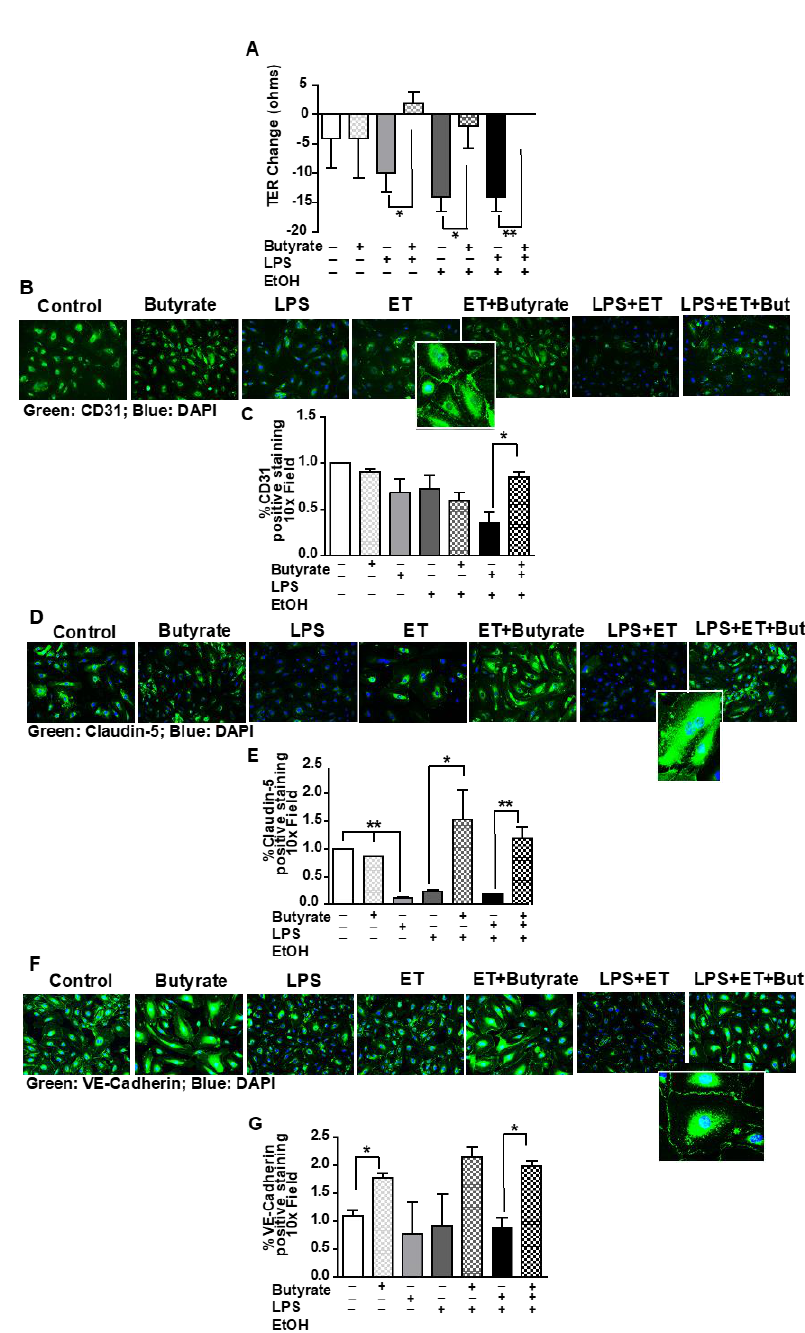
Figure 6. E ff ect of synbiotic on human umbilical vein endothelial cell culture (HUVEC) integrity to ethanol and / or LPS exposure. Confluent HUVEC monolayers seeded on transwells and / or on glass coverslips in a 24-well culture plate were exposed to ± ethanol (40 mM), ± LPS (1 µ g / mL), and ± sodium butyrate (2 mM) on the apical surface for 6 h. ( A ) Transendothelial resistance (TER-ohms) was measured at baseline and 6 h after treatment using a World Precision volt / ohm meter electrical resistance system. TER values represent changes between baseline and 6 h exposures. Data are the mean ± SEM of five independent experiments performed in duplicate. Immunostaining was performed for ( B , C ) CD31 (green); ( D , E ) Claudin-5 (green); and ( F , G ) VE-cadherin (green). All images were acquired using a 10x objective, and a selected area was cropped an enlarged. Images are representative of at least replicate images captured in three independent experiments. Immunofluorescent images were semi-quantified. ** p < 0.001; * p < 0.05. Lipopolysaccharide (LPS); Ethanol (ET); Butyrate